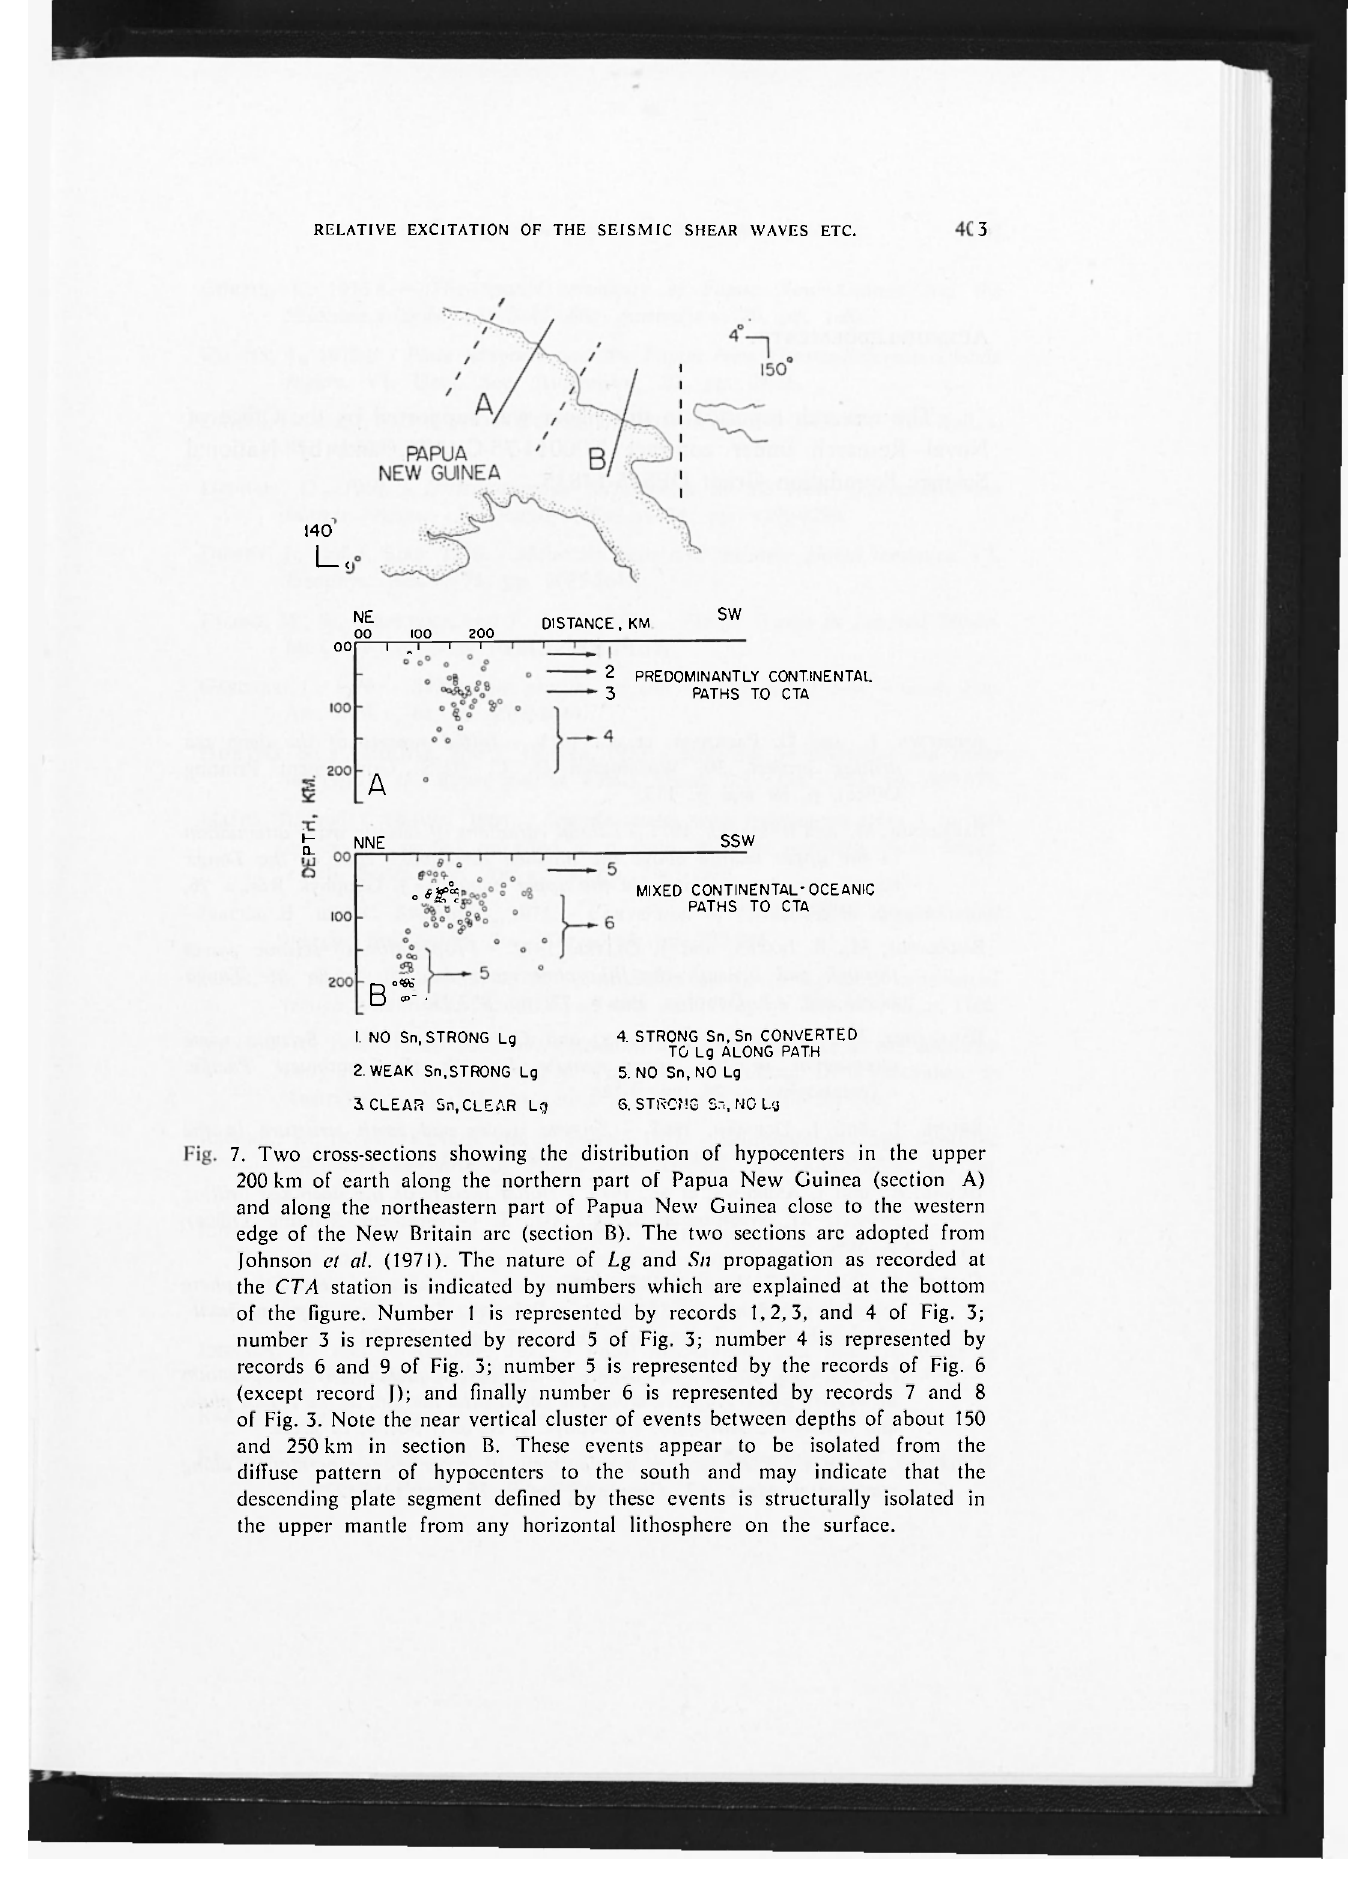
7. Two cross-sections showing the distribution of hypocenters in the upper 200 km of earth along the northern part of Papua New Guinea (section A) and along the northeastern part of Papua New Guinea close to the western edge of the New Britain arc (section B). The two sections arc adopted from Johnson et al. (1971). The nature of Lg and Sn propagation as recorded at the CTA station is indicated by numbers which are explained at the bottom of the figure. Number 1 is represented by records 1,2,3, and 4 of Fig. 3; number 3 is represented by record 5 of Fig. 3; number 4 is represented by records 6 and 9 of Fig. 3; number 5 is represented by the records of Fig. 6 (except record J); and finally number 6 is represented by records 7 and 8 of Fig. 3. Note the near vertical cluster of events between depths of about 150 and 250 km in section B. These events appear to be isolated from the diffuse pattern of hypocenters to the south and may indicate that the descending plate segment defined by these events is structurally isolated in the upper mantle from any horizontal lithosphcre on the